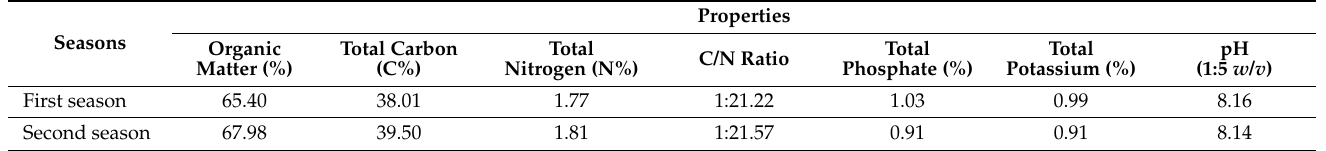
Table 10. Physical and chemical properties of biochar used in the current